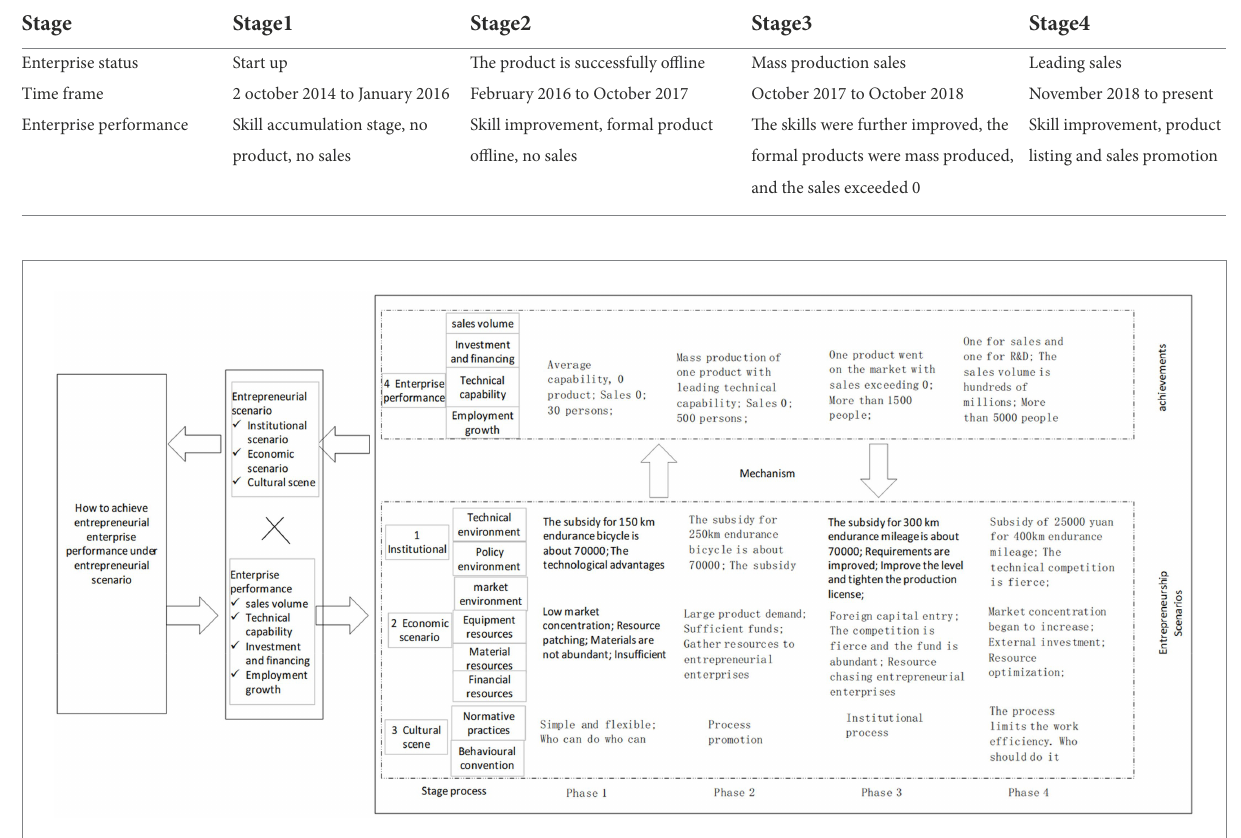
FIGURE 2 Analysis process of the case company